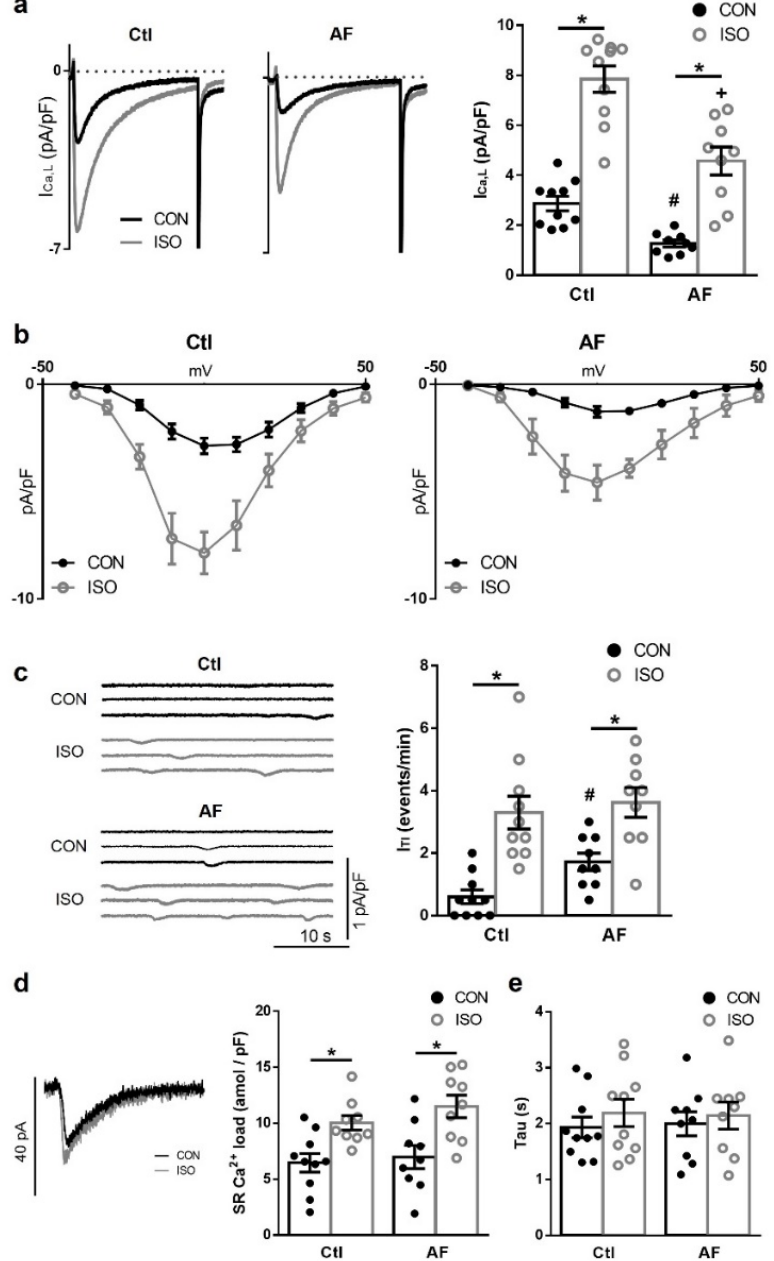
Figure 3. Effect of β -adrenergic stimulation on I Ca,L , I TI and sarcoplasmic reticulum (SR) Ca 2+ load. ( a ) ( left ): Representative I Ca,L recordings in myocytes from a sinus rhythm (Ctl) patient and a patient with atrial fibrillation (AF), before (CON, black trace) and after exposure of the myocyte to 30 nM isoproterenol (ISO, grey trace). ( right ): Average effects of ISO in Ctl and AF patients. ( b ) Mean current-voltage relationship for I Ca,L in Ctl and AF myocytes before and after exposure to ISO. ( c ) ( left ): Representative recordings of I TI before and after ISO in Ctl and AF. ( right ): Average effects of ISO on I TI in Ctl and AF myocytes. ( d ) ( right ): Representative recordings of caffeine-induced NCX-currents before and after ISO. ( left ): Average ISO effect on SR Ca 2+ load in Ctl and AF. ( e ) Average ISO effect on time constant (Tau) in Ctl and AF. Significant differences between treatments are indicated with *, between groups with